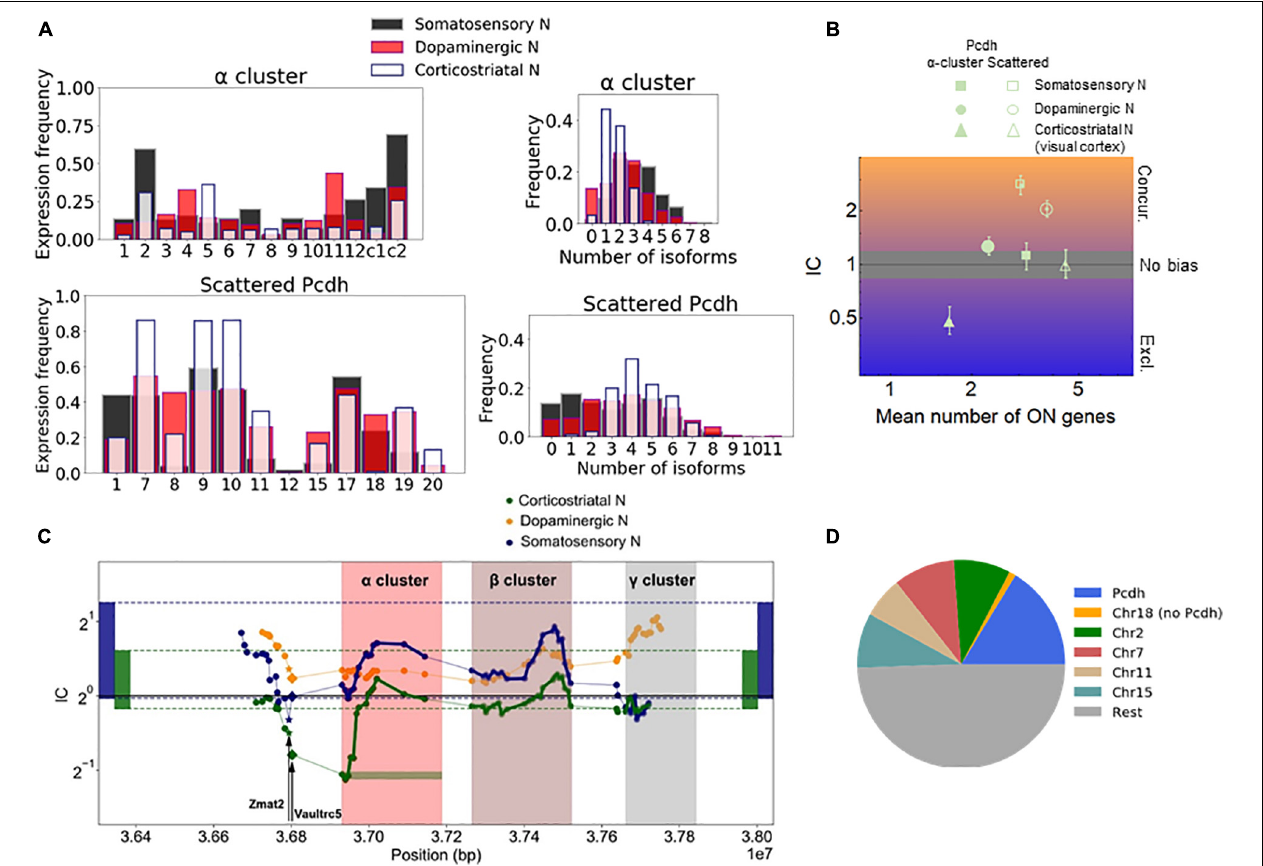
FIGURE 3 | Chromosomal segments with stochastic exclusive gene choice in multiple cell types. (A) The expression of the Pcdh α -array and the scattered Pcdhs in different neuronal types. The expression frequency indicates the proportion of cells expressing a particular gene isoform. The distribution of the number of expressed gene isoforms per cell indicates the proportion of cells expressing 0, 1, 2 or more isoforms per cell at the RNA level. (B) The IC values calculated from the data shown in (A) . The error bars denote the 95% confidence intervals obtained by bootstrapping. (C) The IC of segments with 14 genes along the chromosome. The symbols indicate the position of the most upstream gene in each segment. A full segment is denoted by the green horizontal rectangle, at the first gene of the Pcdh- α cluster. The two genes upstream of the Pcdh α cluster (Vaultrc5 and Zmat2) are marked with a star and diamond. The rectangles located at the two extremes of the plot indicate the 2.5 and 97.5 percentiles of the IC distribution calculated for the chromosomal segments in the genome. (D) The number of chromosomal segments with exclusive gene choice (as shown in Supplementary Figure 5 ) in each chromosome for all cell types